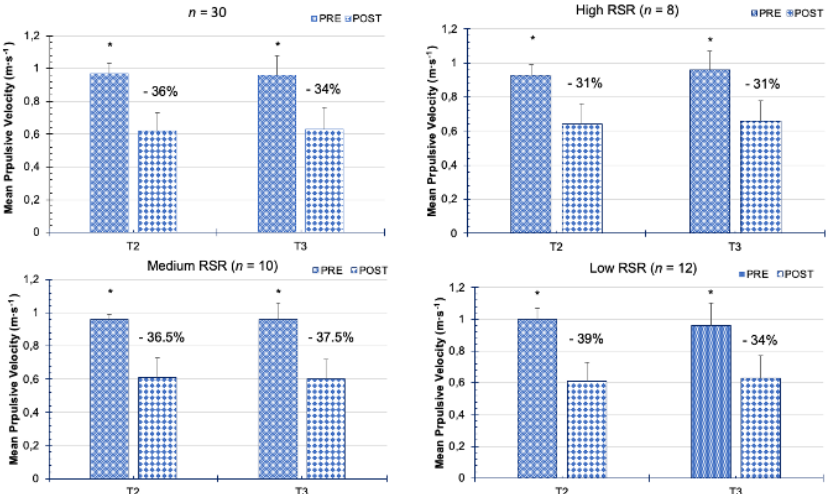
Figure 5. Mean Propulsive Velocity at 1 m · s − 1 Tests pre and post bench press exercise protocol. T2 = second session TEST; T3 = third session RETEST. * = significant difference between pre and post exercise protocol ( p <